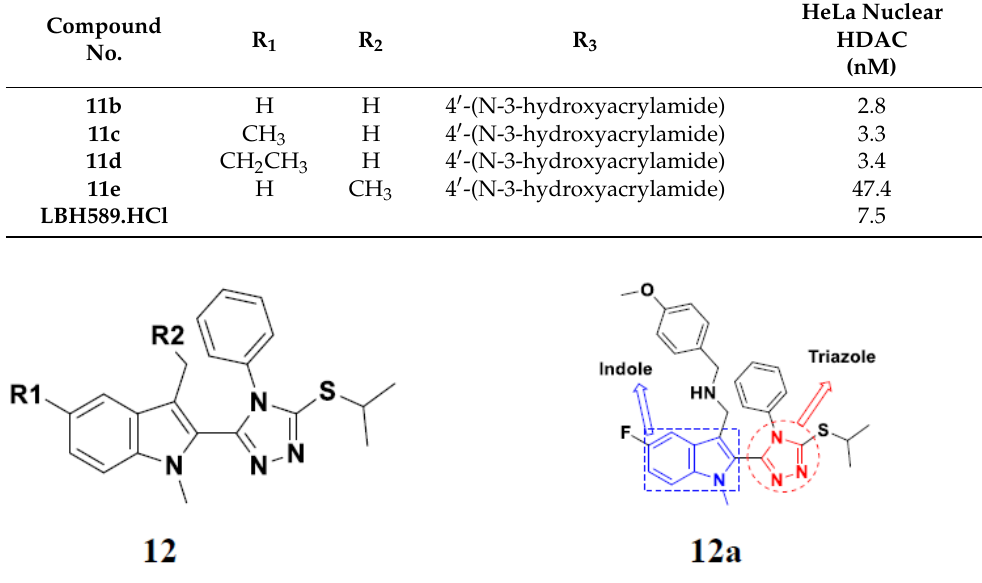
Figure 14. Structure of indole-triazole based hybrids and the most promising compound 12a . Table 12. In vitro cytotoxic activities of indole-triazole based hybrid compounds 12 ( b – e ). Compound